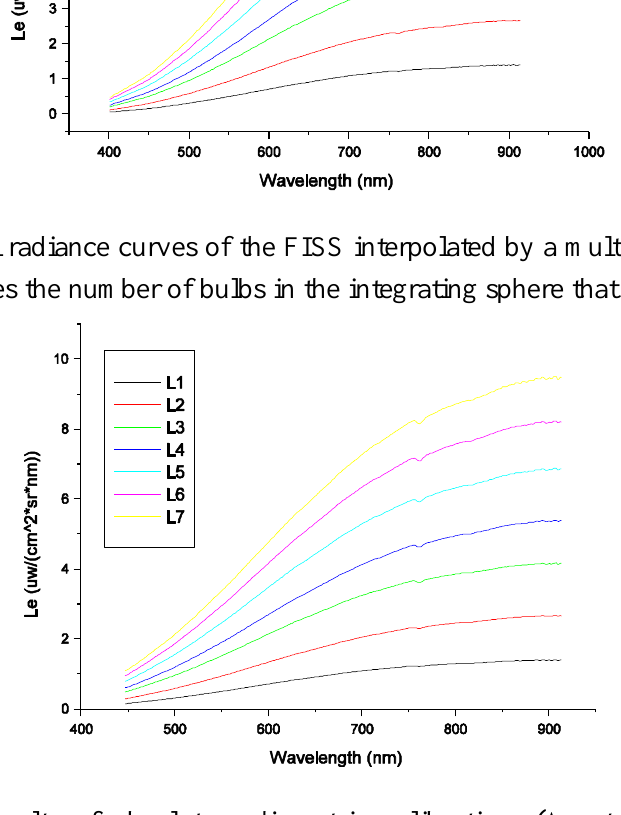
Table 3. Partial results of absolute radiometric calibration. (Aperture size, F/8; CCD cooling temperature, 10 °C; integration time, 30